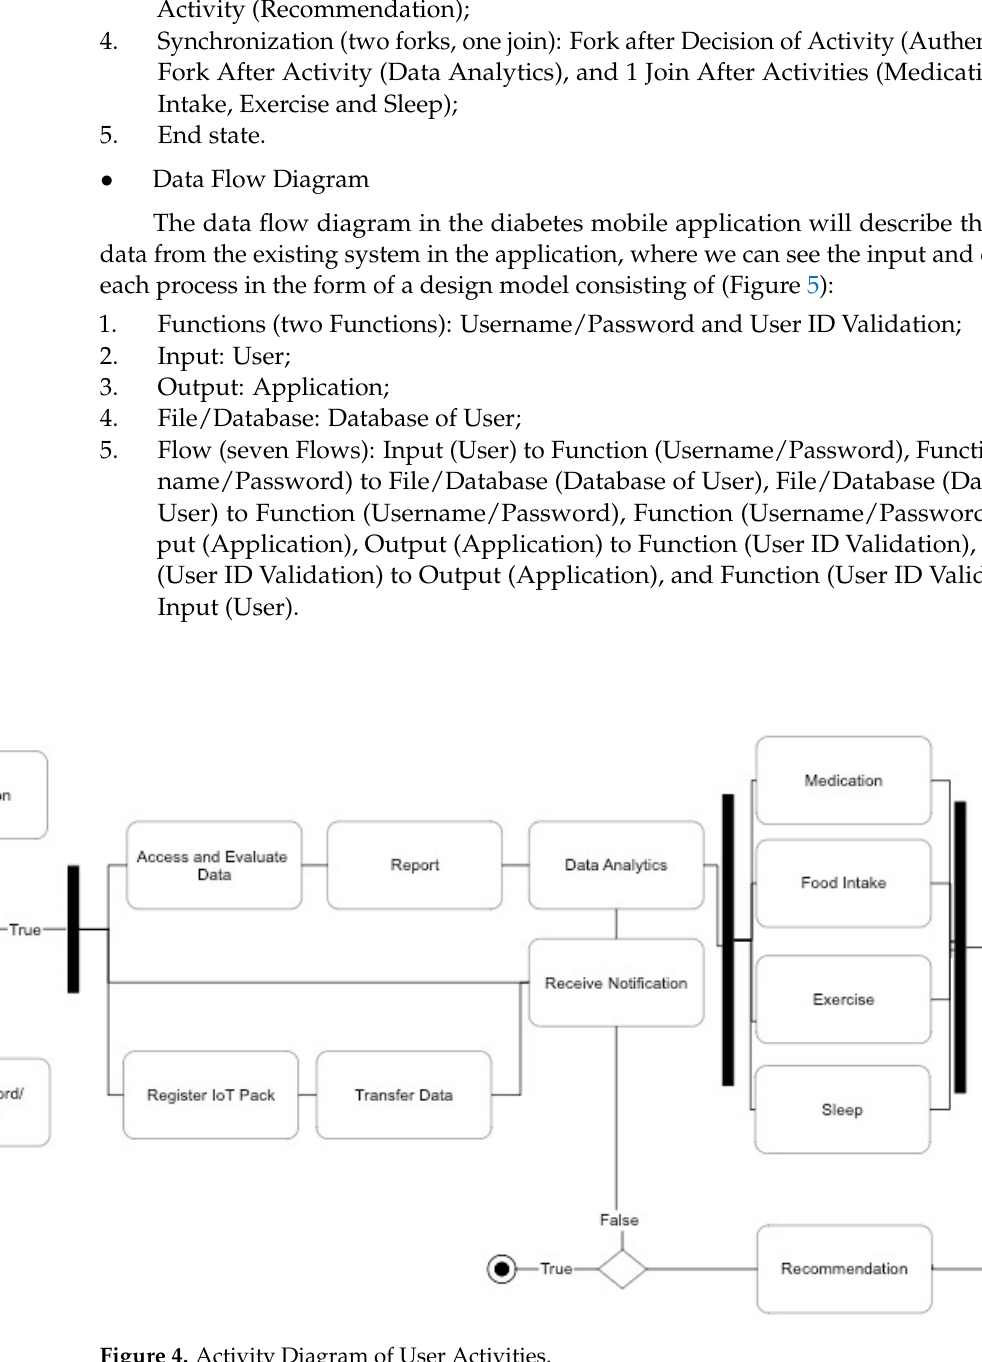
Figure 4. Activity Diagram of User Activities.